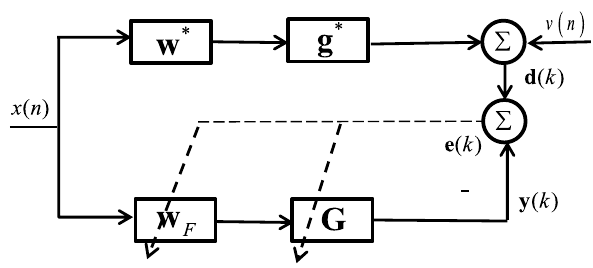
Figure 14. The structure of FDSAF-MCC nonlinear system